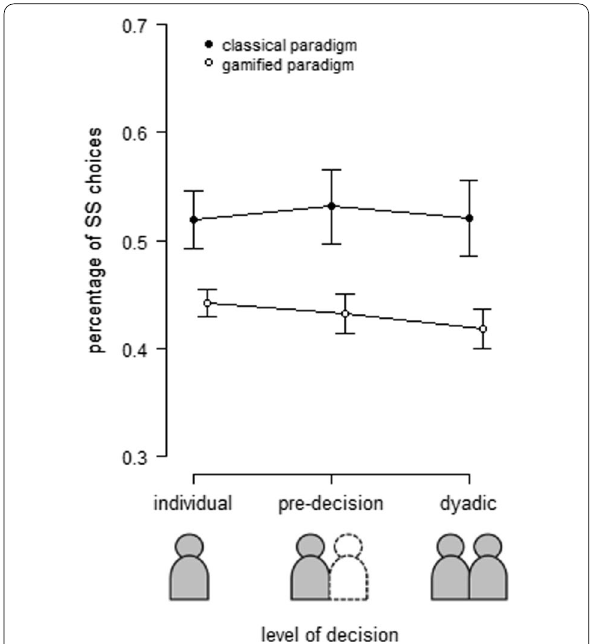
Fig. 4 Results of confirmatory analyses of Experiment 2. Relative frequency of SS choices in different levels of decision-making (individual decision, pre-decision, dyadic decision). Error bars indicate standard errors of the mean